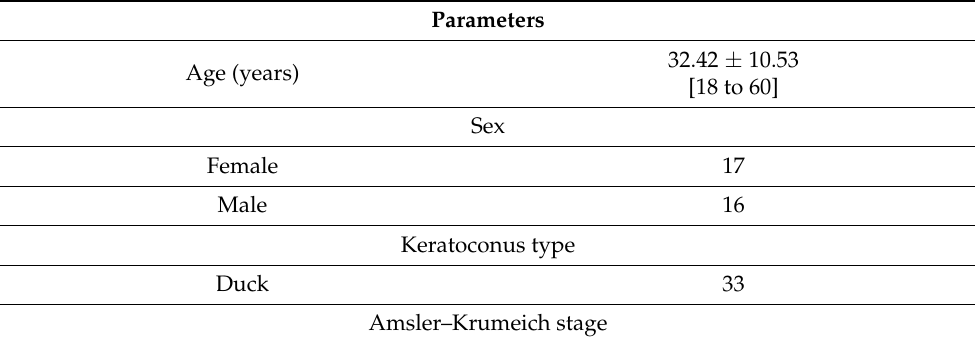
Table 1. Patient demographics and ocular characteristics at inclusion ( n =